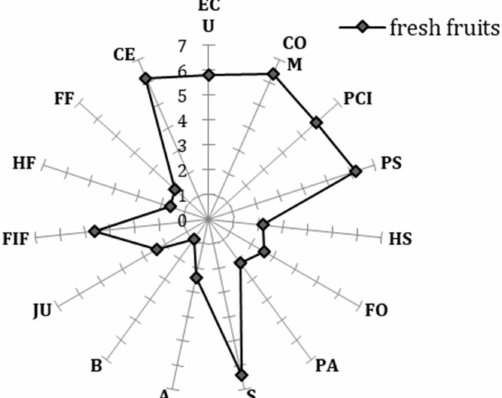
Figure 7. Sensory profile in white flesh melting peaches ( P. persica ) cv Settembrina after harvest. n = 15 for each stage and treatment. Descriptors: external color uniformity ( ECU ); compactness ( COM ); pulp color intensity ( PCI ); peach smell ( PS ); herbaceous smell ( HS ); floral odor ( FO ); pasty ( PA ); sweet ( S ); acid ( A ); bitter ( B ); juicy ( JU ); peach flavor ( FIF ); herbaceous flavor ( HF ); floral flavor ( FF ), and comprehensive evaluation ( CE